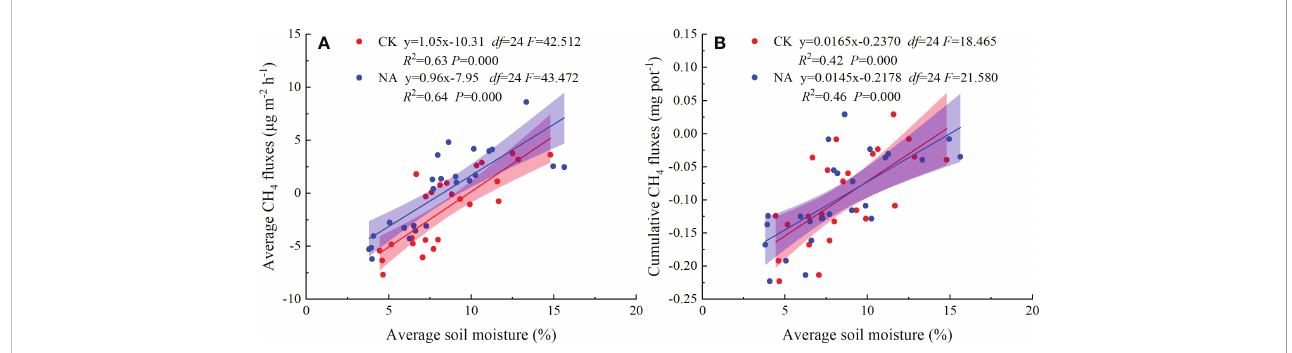
FIGURE 7 The relationship between CH 4 fl uxes ( (A) : average fl uxes; (B) : cumulative fl uxes) and average soil moisture after the precipitation pulses and long-term N addition treatments.